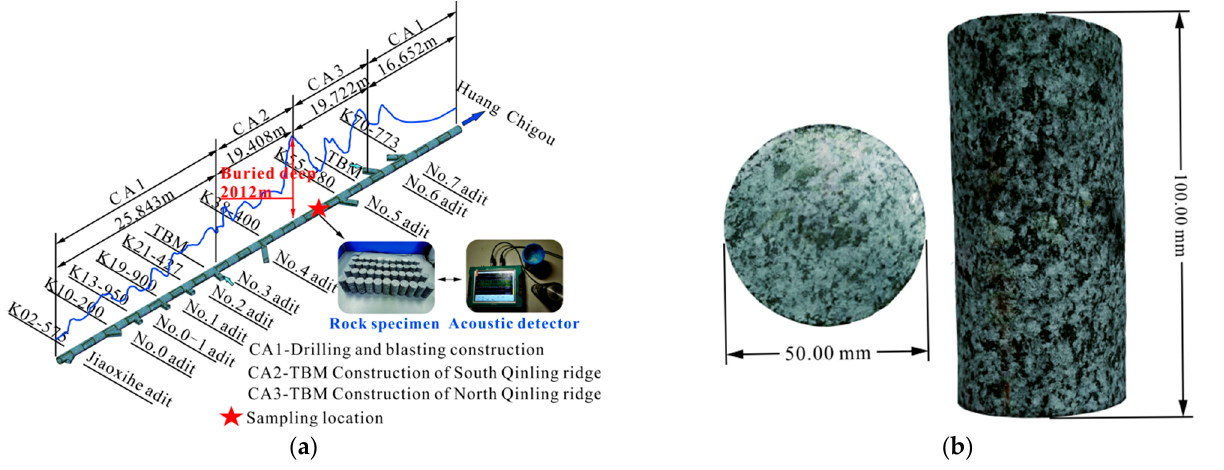
Figure 1. Sample position and size: ( a ) Position of rock sample source, ( b ) Rock sample size.